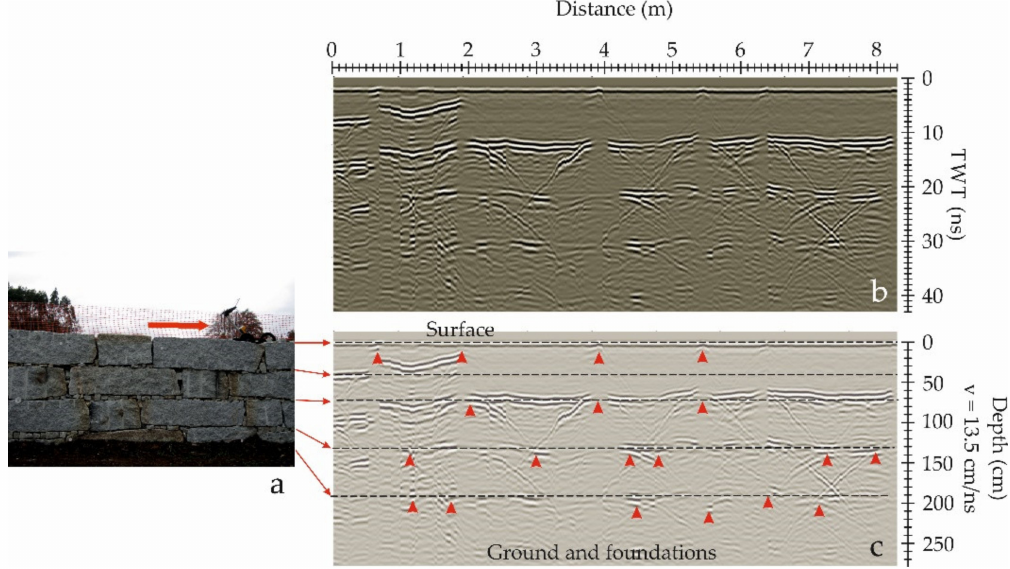
Figure 6. GPR assessment of masonry walls composed by granite ashlars. ( a ) The data were acquired from the upper part of the retaining wall. ( b ) GPR image. ( c ) Interpreted radargram, showing the contact between the different rows of ashlars and the anomalies produced by the contact between stones (red arrows) (adapted from Solla et al.